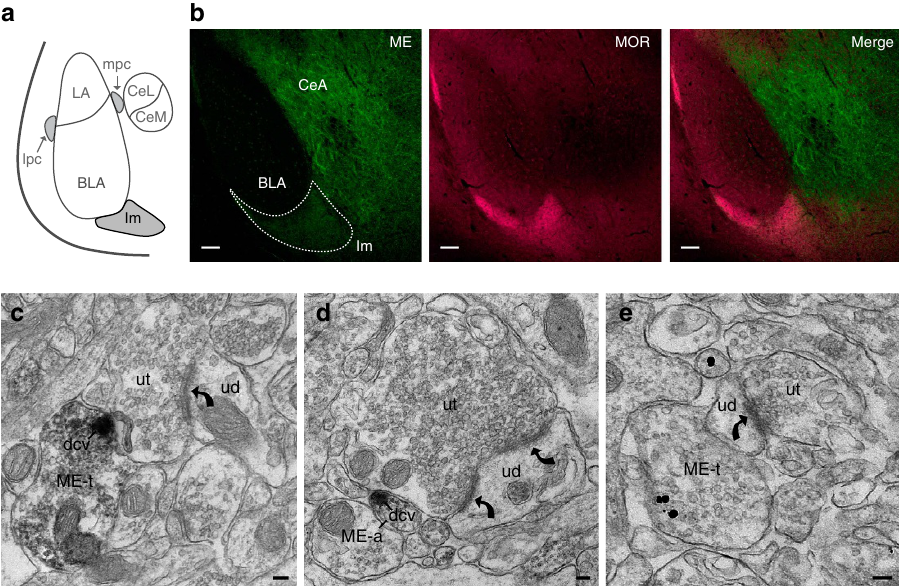
Figure 1 | Met-enkephalin expressed within the main ITC island is positioned to modulate excitatory synapses. ( a ) Schematic of amygdala subdivisions. ITC islands are shaded in grey. BLA, basolateral amygdala; CeL, lateral central amygdala and CeM, medial central amygdala make up the central amygdala (CeA); Im, Main ITC island; lpc, lateral ITC; mpc, medial ITC. ( b ) Single confocal images in the amygdala (Bregma (cid:2) 2.00mm) of ME (green), MOR (magenta) and the two merged channels. Im is outlined by the dashed line. Scale bars, 100 m m. ( c – e ) electron micrographs showing: ( c ) ME immunoreactivity is located in an axon terminal (ME-t) and concentrated in a dense core vesicle (dcv) that is directly apposed to an unlabeled terminal (ut) that forms an asymmetric synapse (curved arrow) with an unlabelled dendrite (UD). ( d ) An, unmyelinated axon (ME-a) contains a dense core vesicle that is immunoreactive for ME and is apposed to an unlabeled axon terminal (ut) that forms a perforated asymmetric synapse (curved arrows) with an unlabelled dendrite (UD). ( e ) ME immunogold immunoreactivity is located in an axon terminal (ME-t) apposed to an unlabelled dendrite (ud) that receives an asymmetric synapse (curved arrow) from an unlabelled terminal (ut). Scale bars,